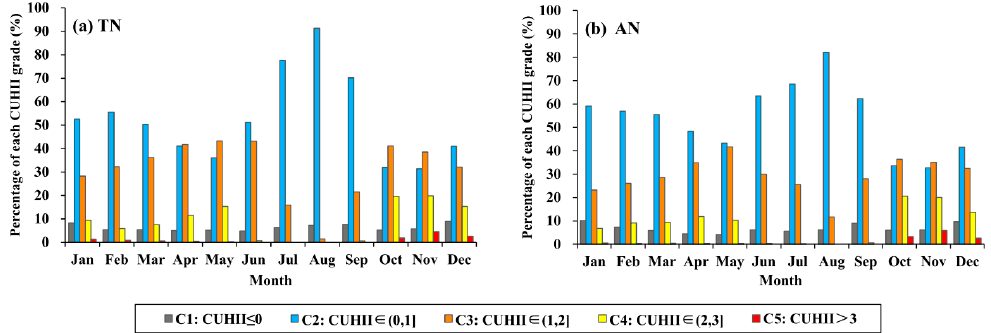
Figure 11. The area percentage of each CUHI intensity grade derived from nighttime CUHI Climatological maps for each month at the: ( a ) Terra nighttime overpass (TN); and ( b ) Aqua nighttime overpass (AN).